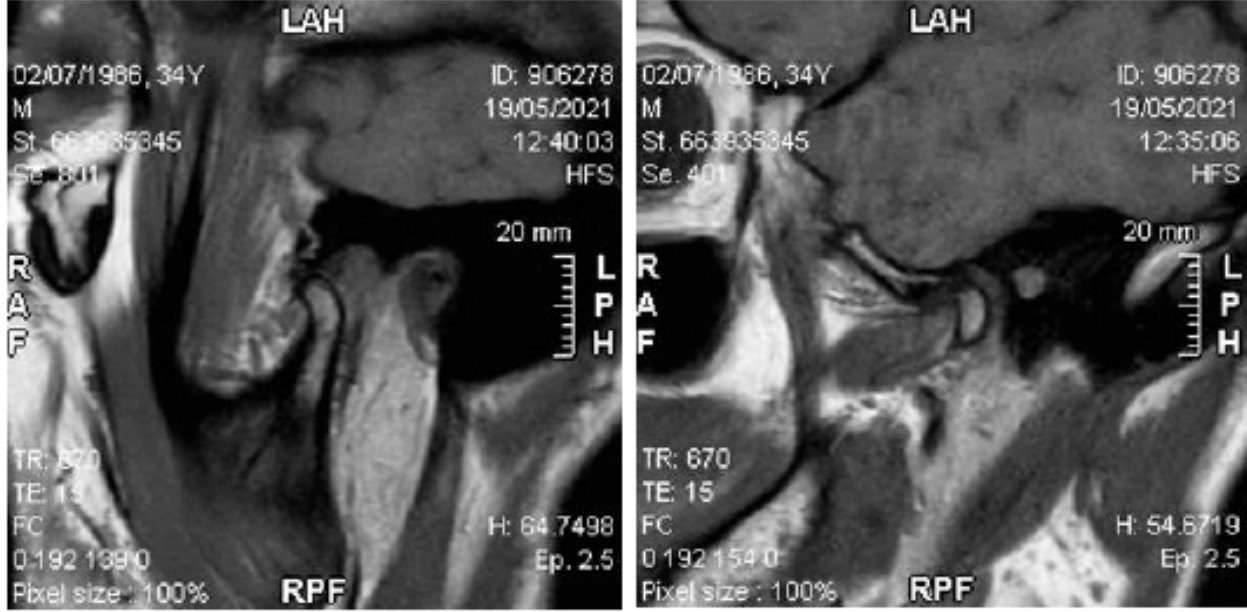
Figure 27. MRI images with a closed and open mouth.